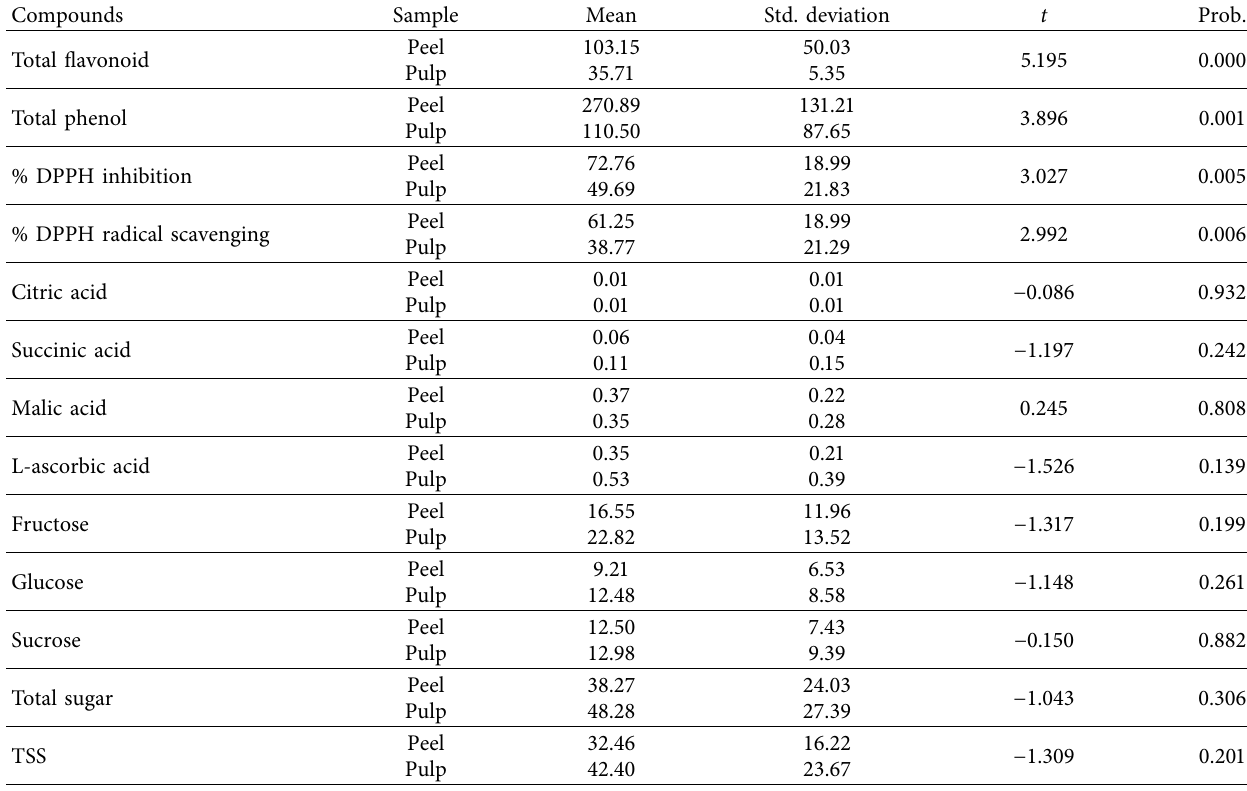
Table 2: t -test results.